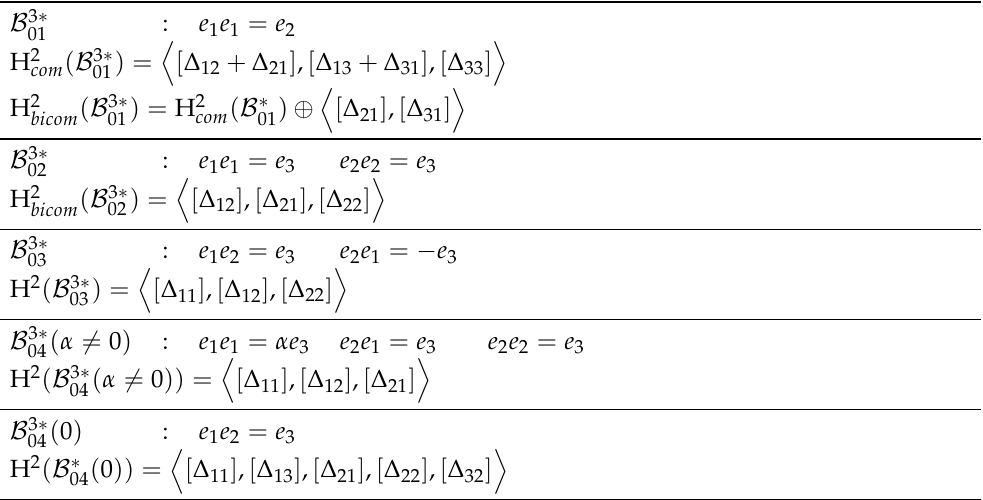
Table 3. The list of two-step nilpotent three-dimensional bicommutative